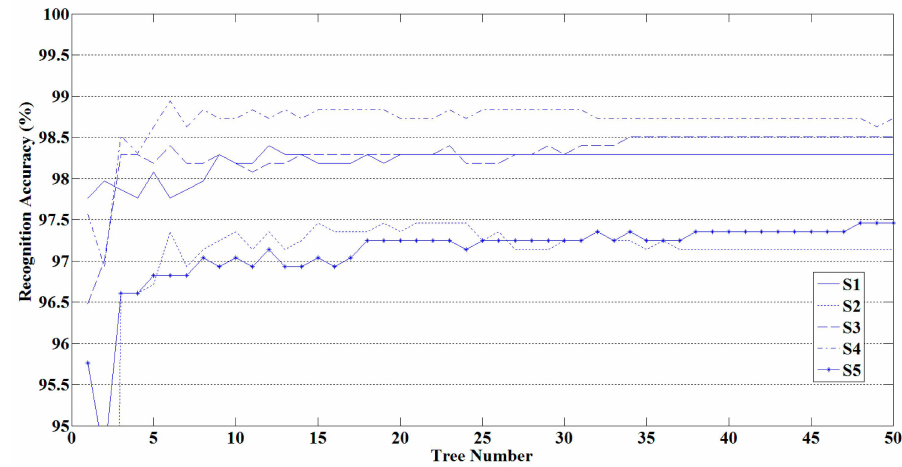
Figure 8. Relationship between the number of decision trees in a random forest and the recognition